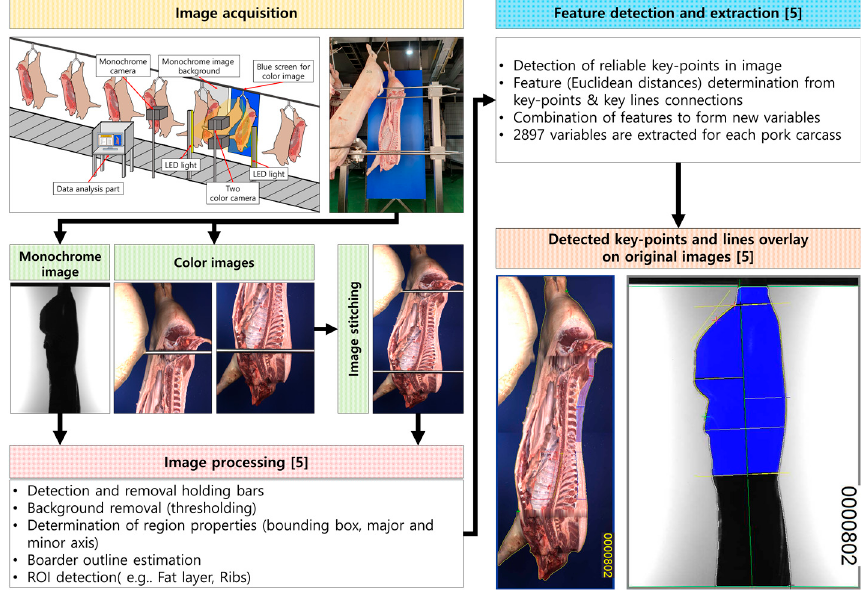
Figure 1. Summary of image processing and feature selection for the VCS2000 system [5].